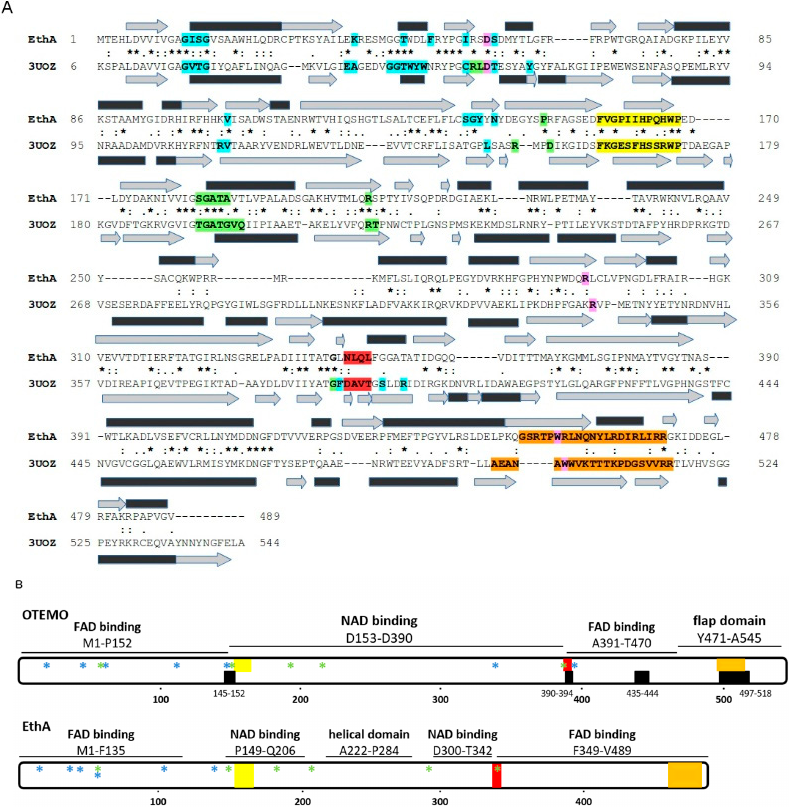
Figure 1. Comparison of EthA and OTEMO sequence and features. ( A ) Sequence alignment between EthA and 3UOZ visualized by Pymol Schrodinger llc v2.1.0. Rectangles and arrows represent helices and strands, respectively. Residues mapped by PLIP [23] as contributing to the FADH 2 and NADP binding sites are shown in cyan and green, respectively; catalytic arginines are shown in purple; residues in pink contribute to ETH binding in the Acinetobacter radioresistens EthA homolog [26]. Yellow, BVMO motif (EthA, F157-P168; 3UOZ, F160-P171); red, interdomain linker (EthA, G343-L348; 3UOZ, G388-T393); orange, control loop (EthA, G450-R470; 3UOZ, A496-R516). Secondary structure information was obtained with STRIDE [27]. ( B ) Domains and other features of OTEMO and EthA. Yellow, BVMO motif; red, interdomain linker; orange, control loop; black: OTEMO flexible regions or that and / or undergo conformational transitions in crystal structures. Asterisks: amino acids that are part of the FAD (blue) and NADPH (green) binding sites in OTEMO structures (3UOZ, 3UOY, 3UOV, 3UOX, 3UP4, 3UP5) as mapped by PLIP and according to [20]. OTEMO domains are as in [20]. An alignment between PAMO, CHMO, STMO, OTEMO, and EthA [18] was used to infer EthA domains and EthA and OTEMO mobile functional